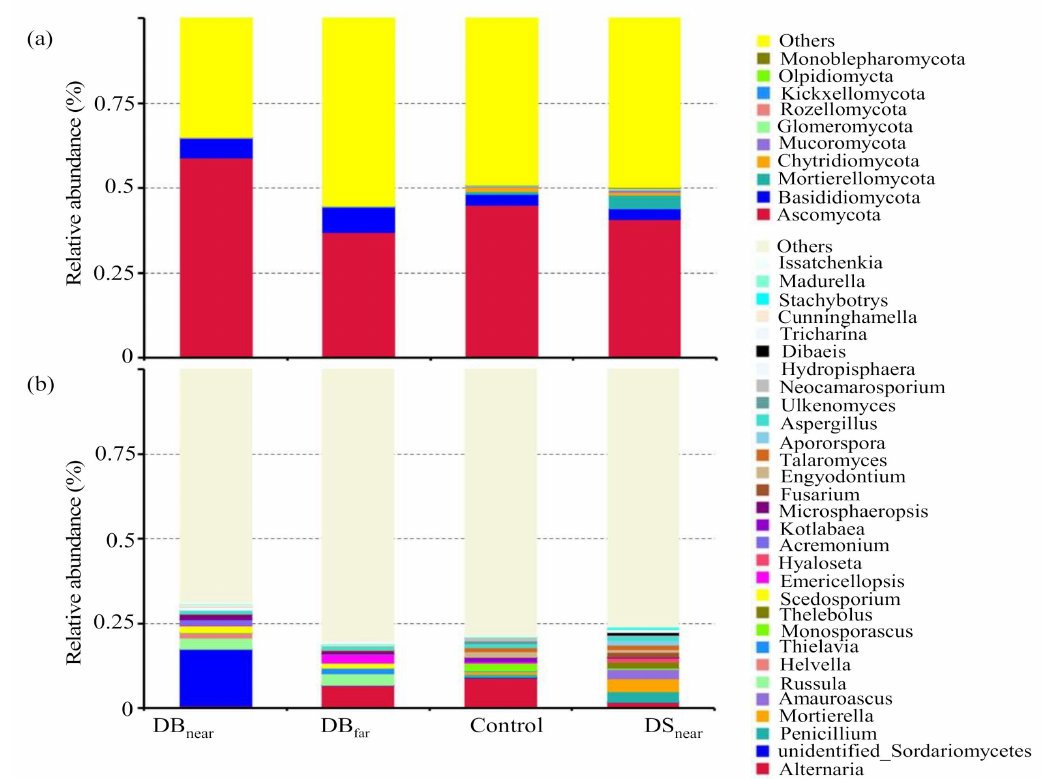
Figure 5. Differences in distribution pattern of the relative abundance of soil fungi among the four plot types at the phylum and genus levels: ( a ) phylum; ( b )